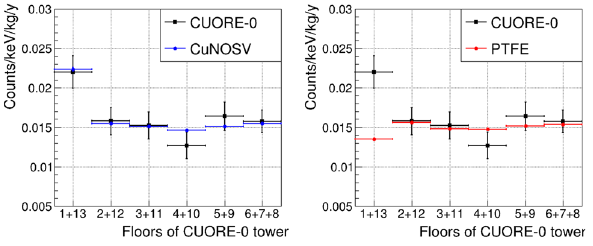
Fig. 4 CUORE-0 plane-by-plane experimental rate in the energy region between 2.7MeV and 3.9MeV ( black points ) compared to the plane-by-plane Monte Carlo simulated rate of a 210 Pb contamination in the NOSV copper detector structure ( left plot ) and to the plane-by- planeMonteCarlosimulatedrateofa 210 Pb contaminationinthecrystal PTFE supports ( right plot ). To increase the statistical significance, the data from detector planes in symmetric positions around the middle of the tower (floor 7) have been grouped